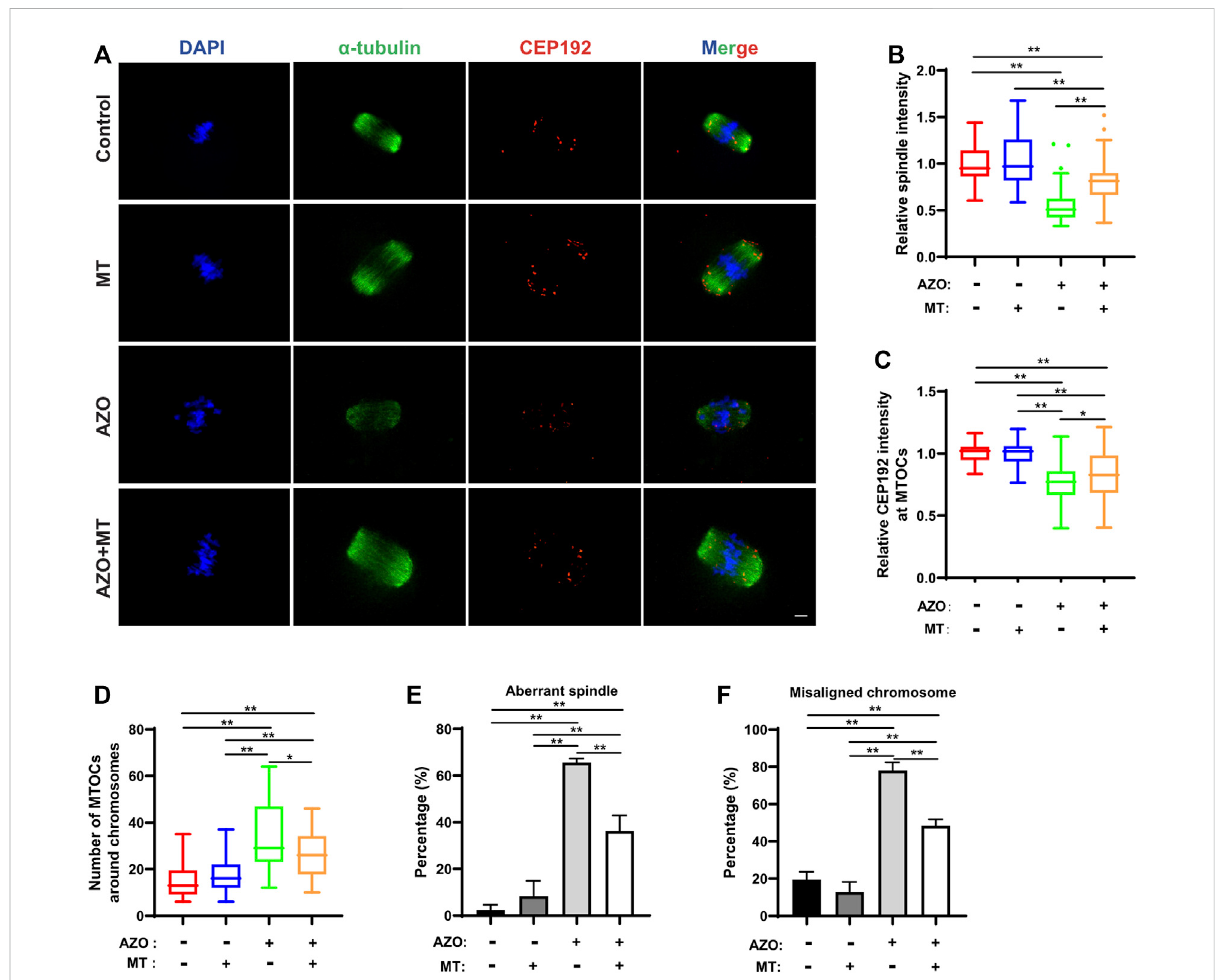
FIGURE 6 Melatonin rescues AZO-induced impairment of spindle assembly. Oocytes were cultured for 8 h in the absence ( − ) or presence (+) of AZO and melatonin (MT) during meiotic maturation. (A) Representative images of oocytes labeled with α -Tubulin and CEP192. Scale bar, 10 μ m. (B,C) The intensities of spindle and CEP192 around MTOCs are quanti fi ed. (D) The number of MTOCs around chromosomes is quanti fi ed using CEP192 fl uorescent foci. (E) The aberrant spindle rate was evident in the control and AZO-treated oocytes at MI stage. (F) The aberrant misaligned chromosome was evident in control and AZO-treated oocytes at MI stage. All data are expressed as mean ± SEM. * p < 0.05, ** p <